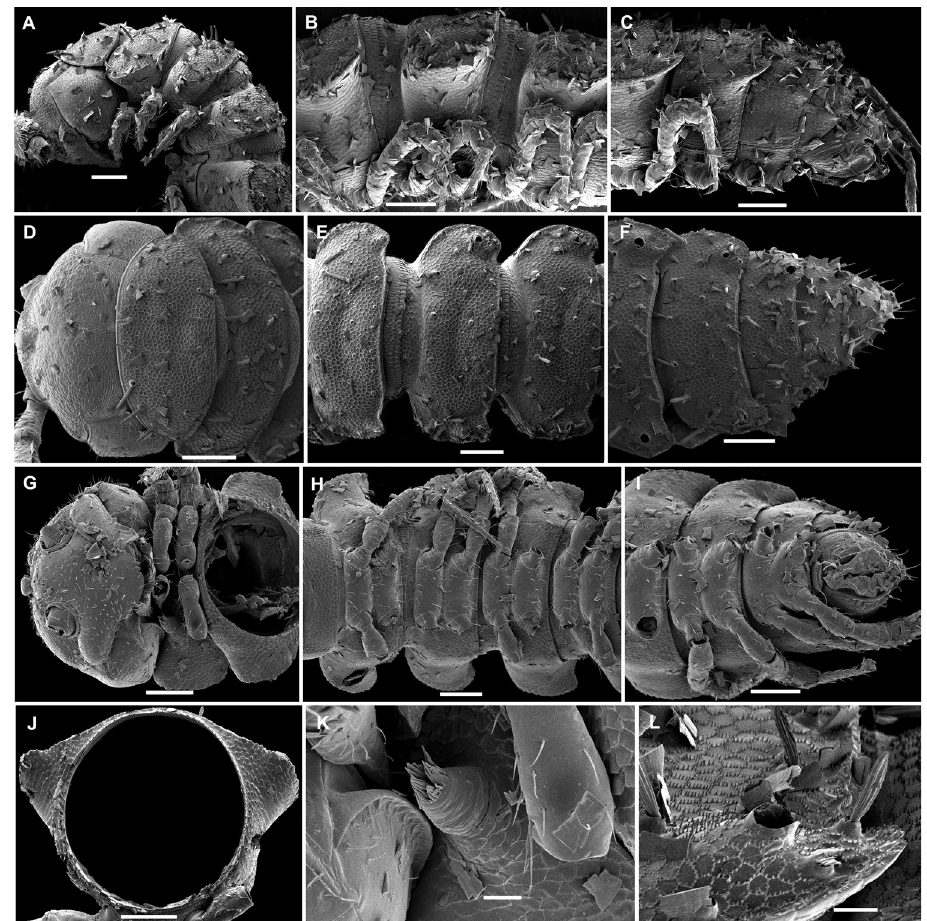
Figure 11. Hemisphaeroparia digitifer sp. n., SEM micrographs of ♂ paratype A, D, G anterior part of body, lateral, dorsal and ventral views, respectively B, E, H midbody segments, lateral, dorsal and ventral views, respectively C, F, I posterior part of body, lateral, dorsal and ventral views, respectively J midbody segment, caudal view K spiracle lateral to coxa 2 L midbody paratergum, lateral view. Scale bars: 0.1 mm ( A–J ), 0.02 mm ( K, L